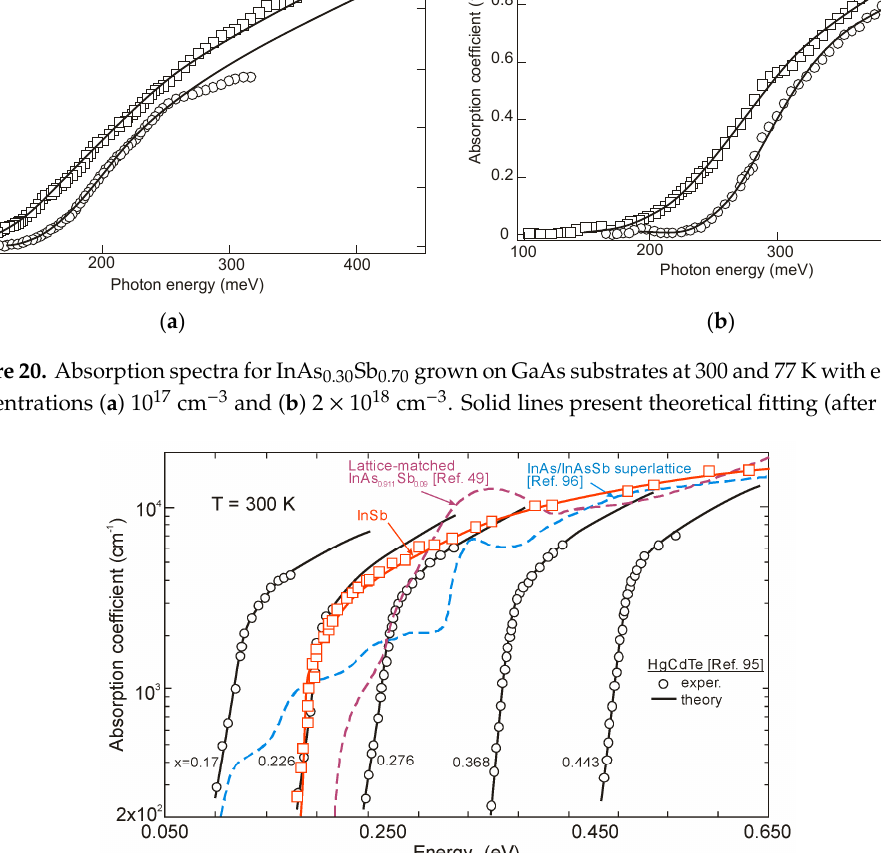
Figure 21. Intrinsic absorption coefficient for Hg 1 − x Cd x Te, InSb, and lattice-matched InAs 0.911 Sb 0.09 and InAs/InAsSb SLs at room temperature.